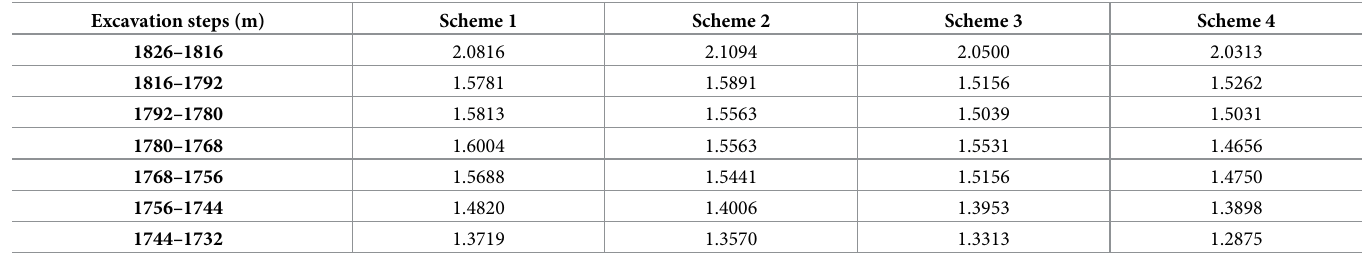
Table 6. Stability coefficients of schemes 1 to